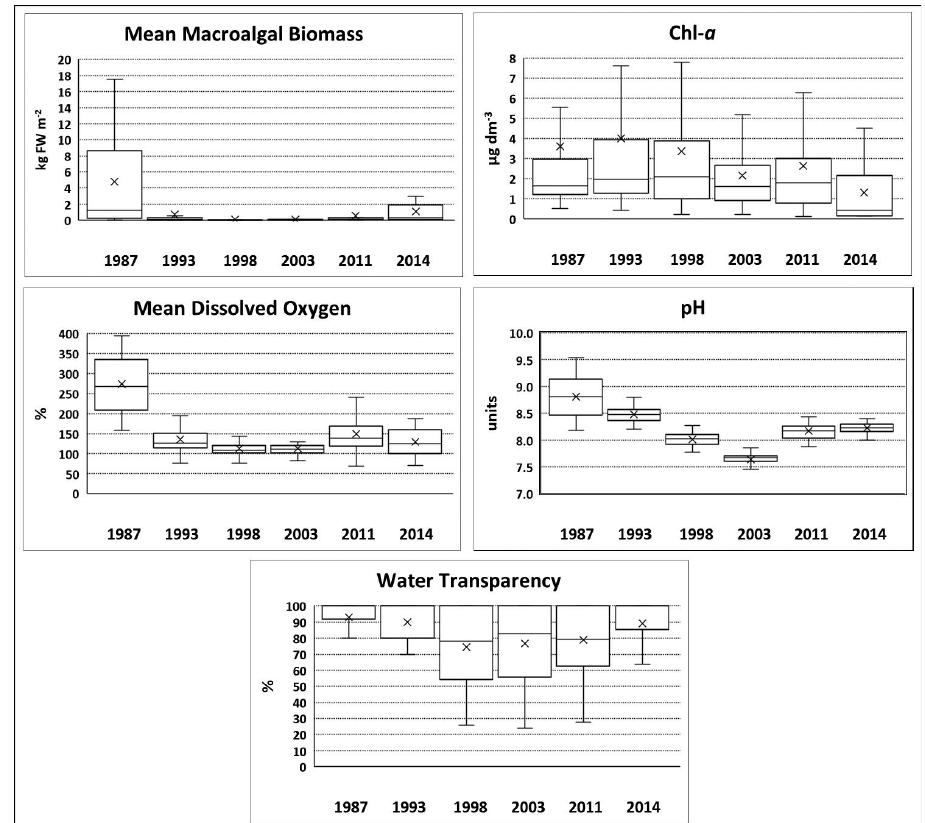
Figure 2. Trends of the mean, standard deviation, maximum, minimum and median values of the mac- roalgal biomass, Chl -a , dissolved oxygen, pH and water transparency in the central lagoon of